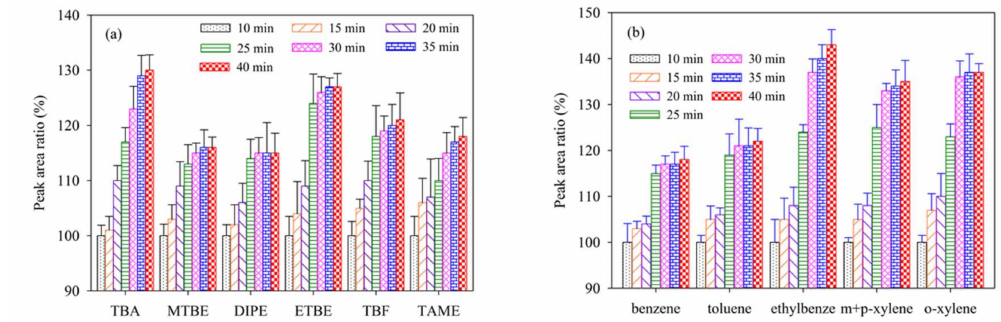
Figure 5. E ff ect of extraction time on signal intensities of the twelve analytes (20 µ g / L). The peak area at the extraction time of 10 min is used as a reference (100%). ( a ) the peak area ratio of TBA, MTBE, DIPE, ETBE, TBF, and TAME; ( b ) the peak area ratio of benzene, toluene, ethylbenze, m + p–xylene, and